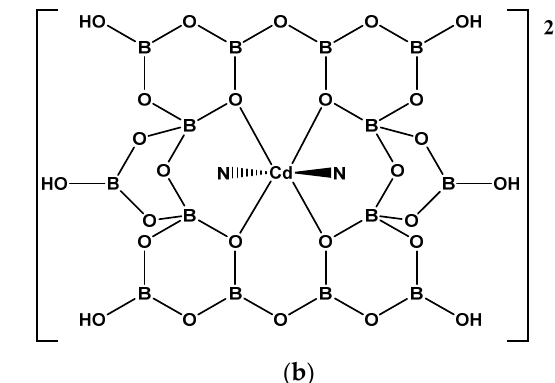
Figure 2. ( a ) The cationic {Cd 3 (H 2 O) 4 (NO 3 ) 2 } 4+ unit of [(Cd 3 ){B 6 O 9 (OH) 2 } 2 (NO 3 ) 2 (H 2 O) 4 ] n ( 5 ). Donor atoms marked O and OH from oxidohexaborate clusters, and ( b ) the building unit of Cd (II) -centered metallaoxidoborate cluster anion, trans -[Cd(py) 2 {B 14 O 20 (OH) 6 }] 2- ( 6 ).